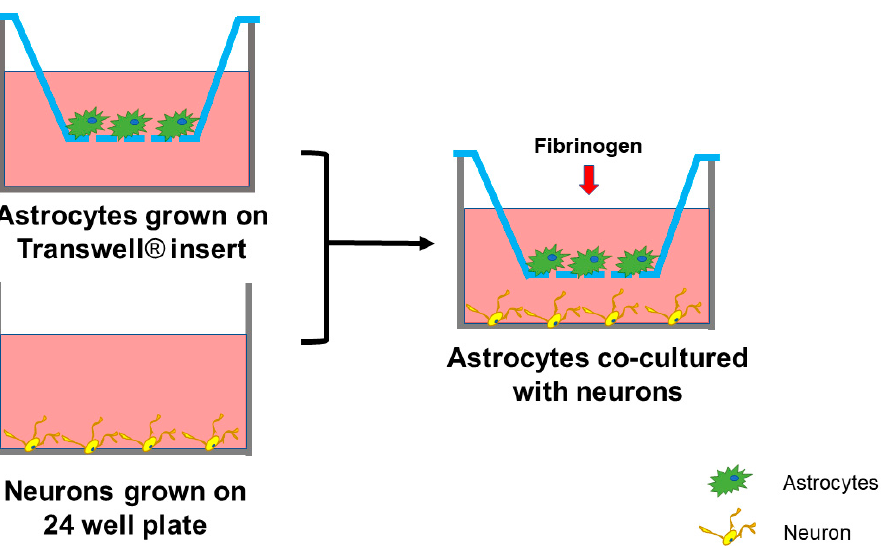
Figure 6. Co-culture of astrocytes and neurons. Neurons were cultured separately in 24-well plates for at least 7 days. Astrocytes were seeded separately on the Transwell ® permeable inserts. Once they reached 80% confluency, the inserts with astrocytes were moved to the wells with cultured neurons. After treating of astrocytes with treatment compounds, the cells were co-cultured for 24 h.